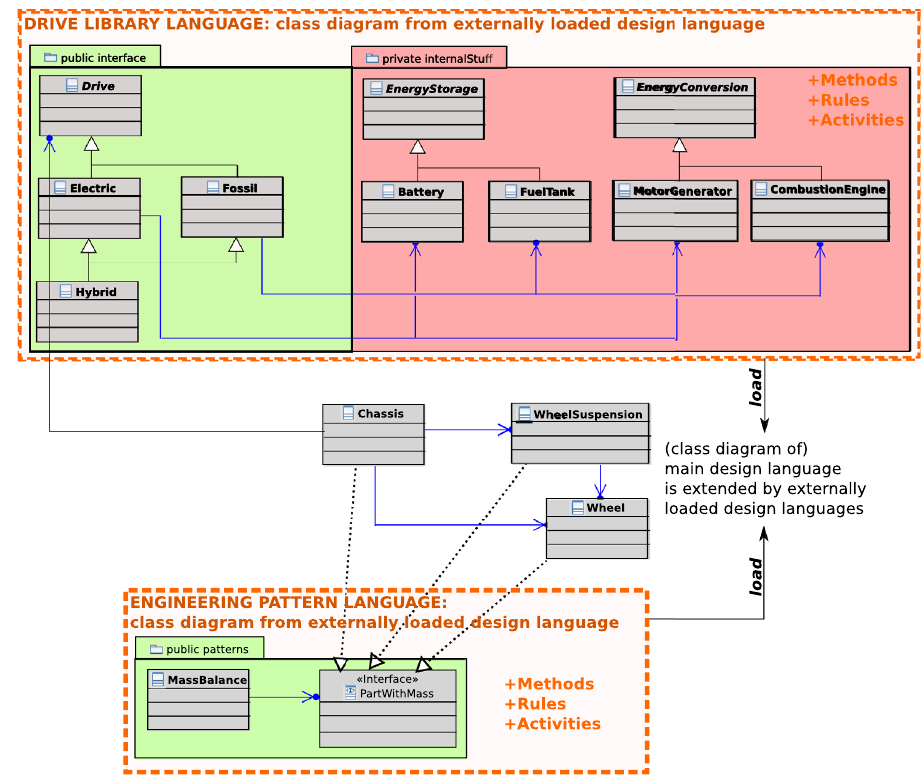
Fig. 10 Encapsulation and modularization: Extending a design language(’s class diagram) through externally loaded design languages (dotted frame) that are encapsulated modules. Only public packages of the external design languages are accessible by the main design language in the